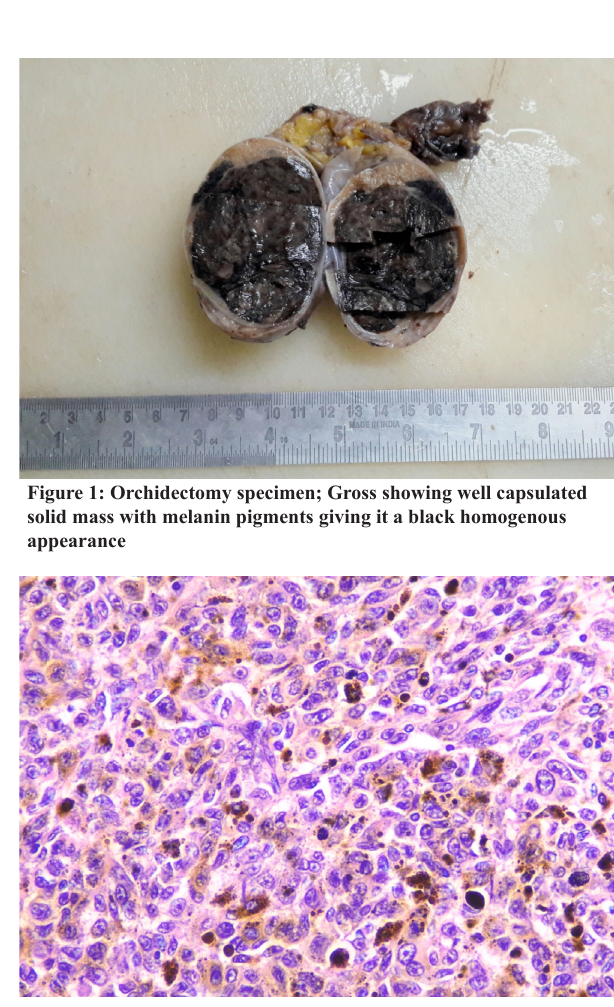
Figure 3: Sheets of melanoma cells with prominent eosinophilic nucleoli and melanin pigments. (H E stain, x